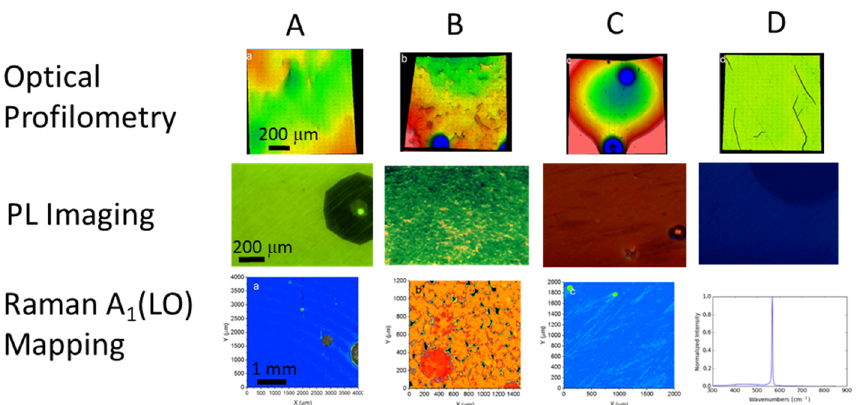
Figure 3. Optical profilometry, PL imaging, and Raman A 1 (LO) mapping of four early substrates. Figure uses copyrighted images, reprinted from [16] with permission from Elsevier.